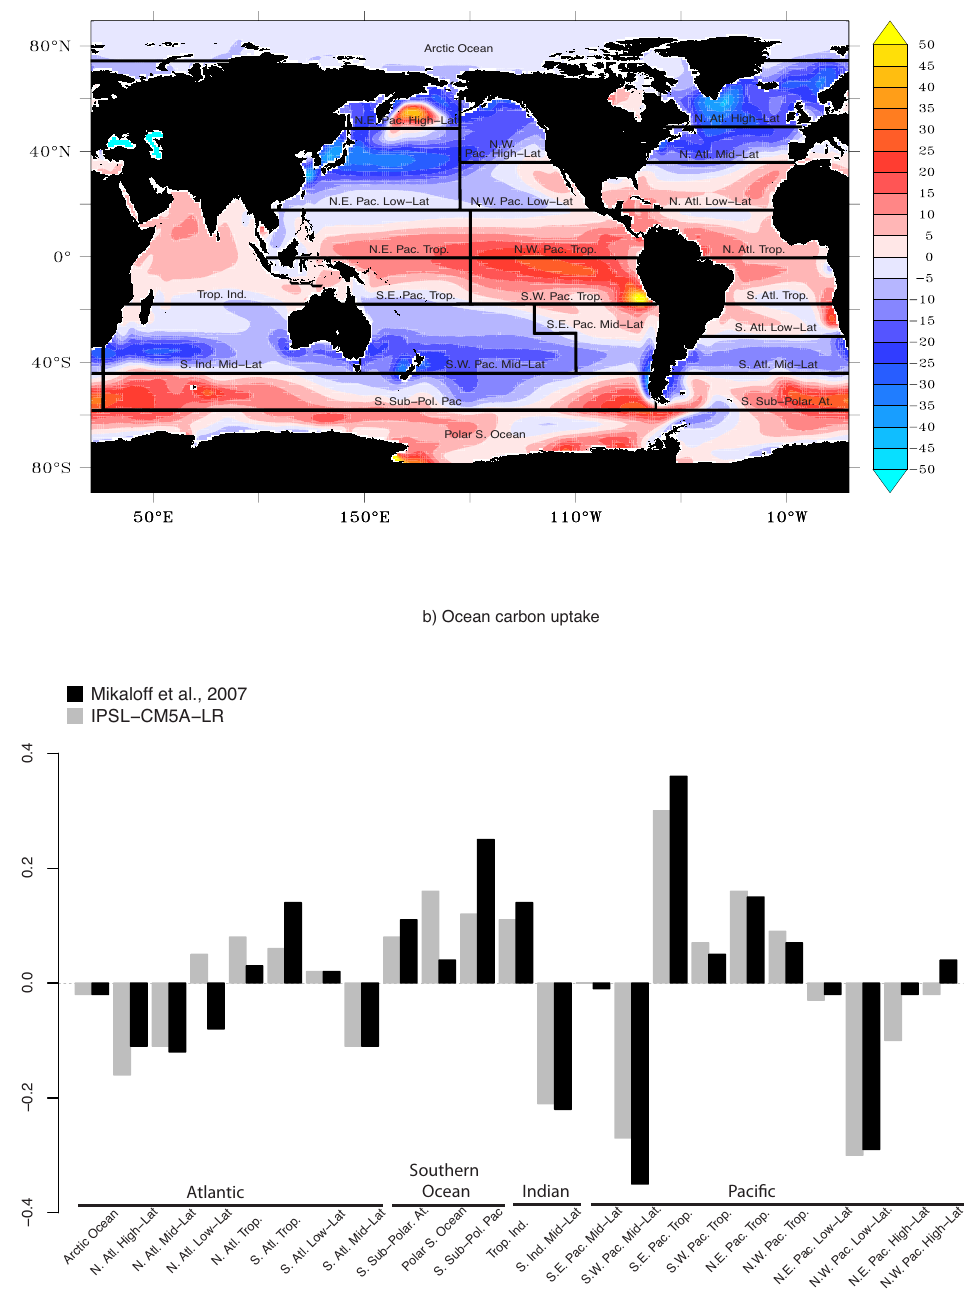
Fig. 1. Long-term mean of (a) simulated ocean carbon fluxes (in gCm − 2 yr − 1 ) and (b) simulated regional carbon fluxes (in PgCyr − 1 ) compared to inversion-based estimates published in Mikaloff Fletcher et al. (2007). Black and grey bars indicate model and inversion-based estimates,